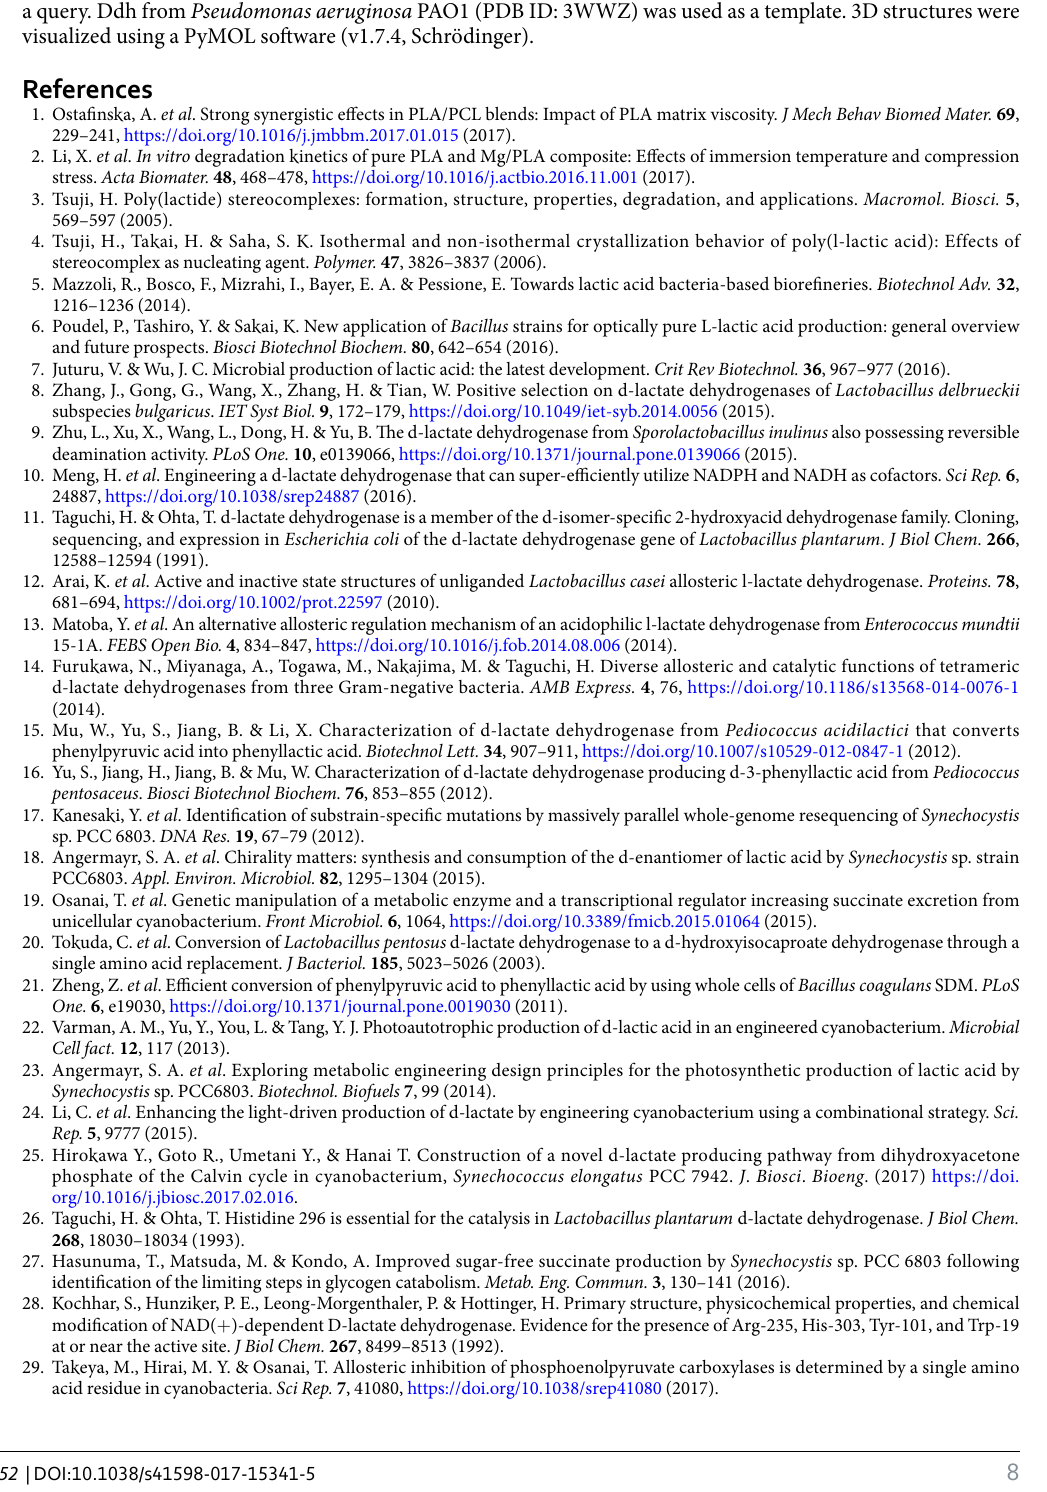
v and V max indicate reaction velocity and maximum reaction velocity, respectively. [S] indicates substrate concen- tration, and S 0.5 indicates the half-maximum concentration giving rise to 50% V max . K i is an inhibition constant, and n H is the Hill coefficient. One unit of Sy Ddh activity was defined as the consumption of 1 μ mol NADH per minute. In silico modelling. Homology modelling of Sy Ddh was performed with a database SWISS-MODEL